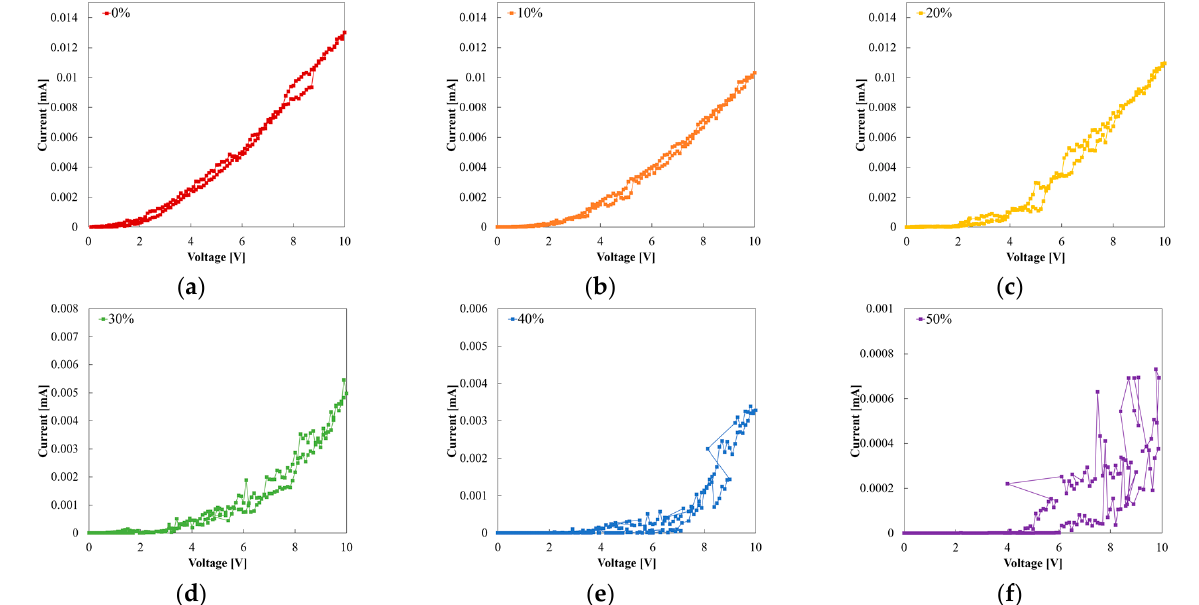
Figure 9. Individual I − V curves of Sample A based on strain: ( a ) 0% strain, ( b ) 10% strain, ( c ) 20% strain, ( d ) 30% strain, ( e ) 40% strain, and ( f ) 50% strain.